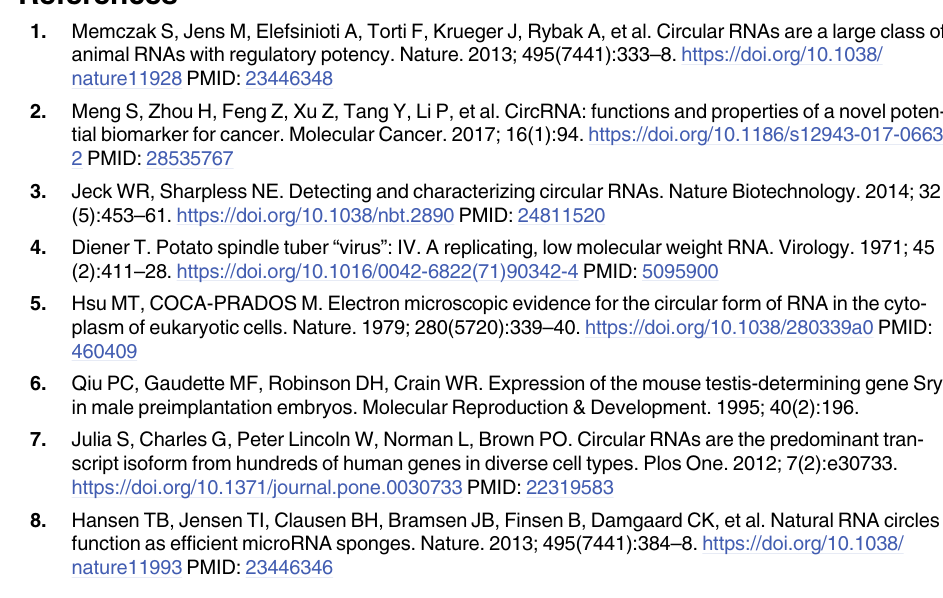
S2 Table. Names of 661 circRNAs involved in known circRNA-disease associations obtained from CircR2Disease database. S3 Table. Names of 100 diseases involved in known circRNA-disease associations obtained from CircR2Disease database. S4 Table. The MeSH dataset that provides rigorous disease classification